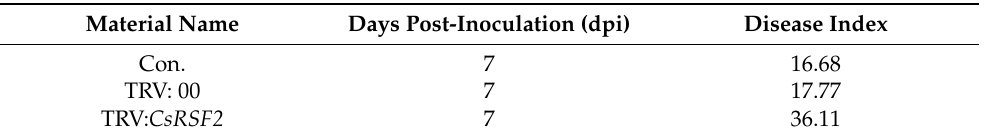
Table 2. Disease index investigation for CsRSF2 transient silencing cucumber cotyledons after S. fuliginea infection.